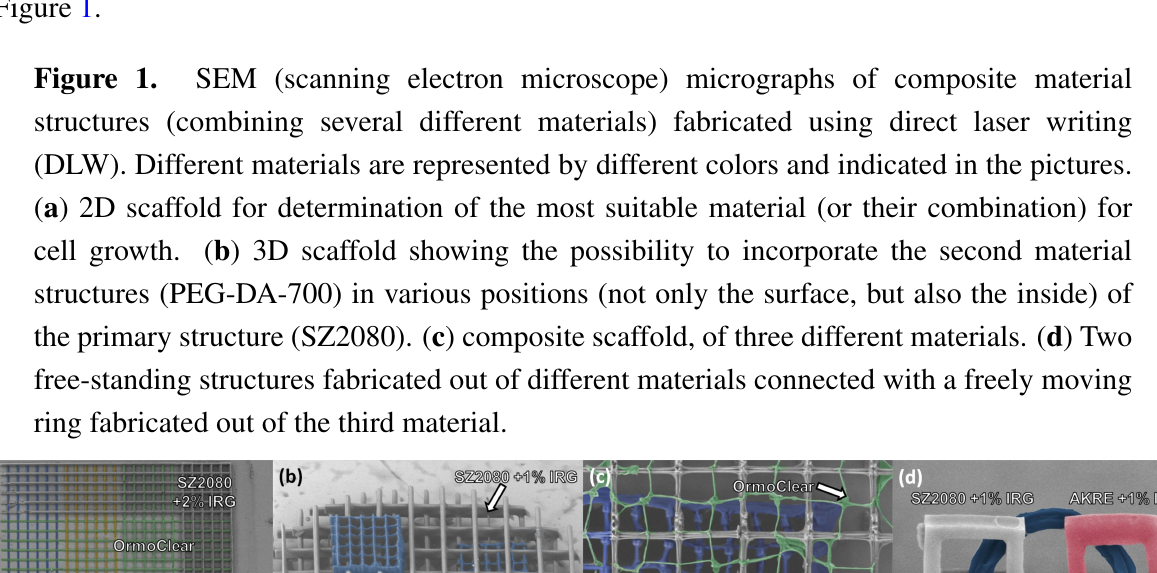
SEM (scanning electron microscope) micrographs of composite material structures (combining several different materials) fabricated using direct laser writing